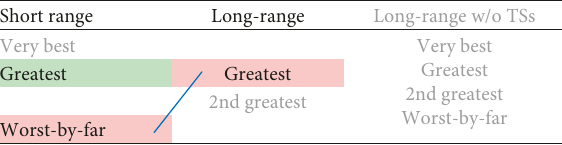
Table 11: Tabular representation of Rule 2.